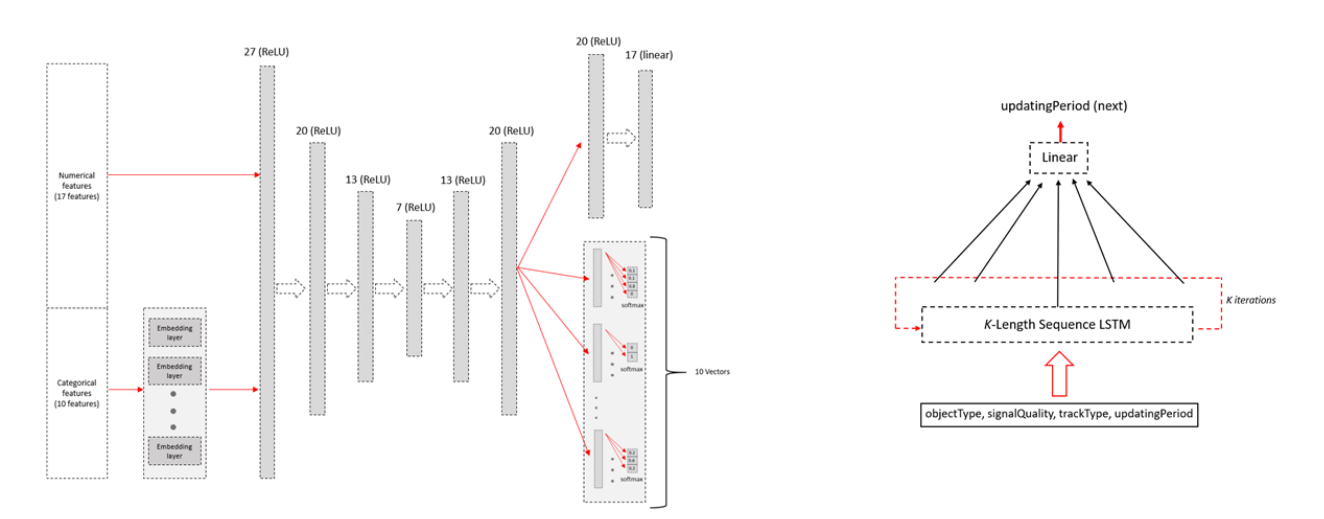
Figure 4. The neural network architecture of the proposed plot-level anomaly detector ( left ) and the neural-network architecture of the proposed sequence-based anomaly detector ( right